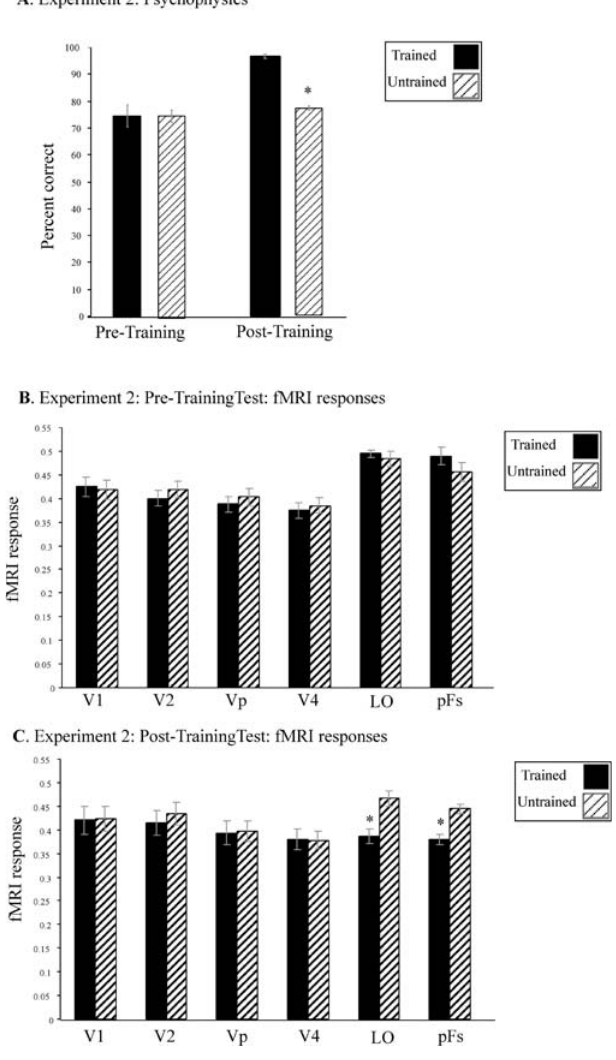
Figure 4. Results for Experiment 2 Psychophysical data (A) and fMRI responses obtained during the scanning sessions before (B) and after (C) training. Error bars indicate the SEM. Significant differences are indicated by asterisks. (A) Psycho- physical data (percent correct) for trained and untrained shapes in the tests before and after training. Normalized fMRI responses across subjects for trained and untrained shapes before (B) and after (C) training across the LOC subregions and early ventral areas. DOI: 10.1371/journal.pbio.0030204.g004